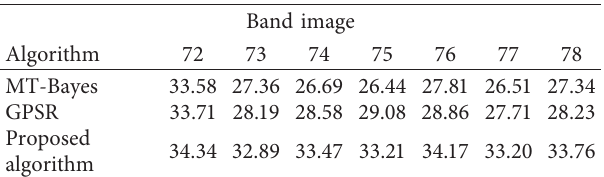
Figure 7: The comparison of the reconstructed effect of the 73rd reference band. (a) Original. (b) MT-Bayes. (c) GPSR. (d) Proposed algorithm. Table 1: The effect comparison of PSNR.